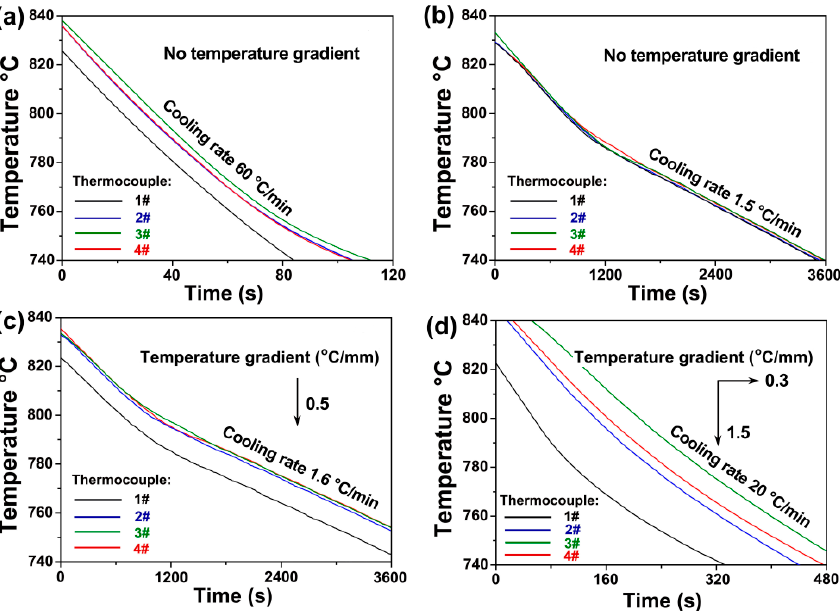
Figure 3. Cooling curves of the Al-30Si alloy with different insulation conditions: ( a ) C I -1, ( b ) C I -2, ( c ) C I -3, ( d ) C I -4.